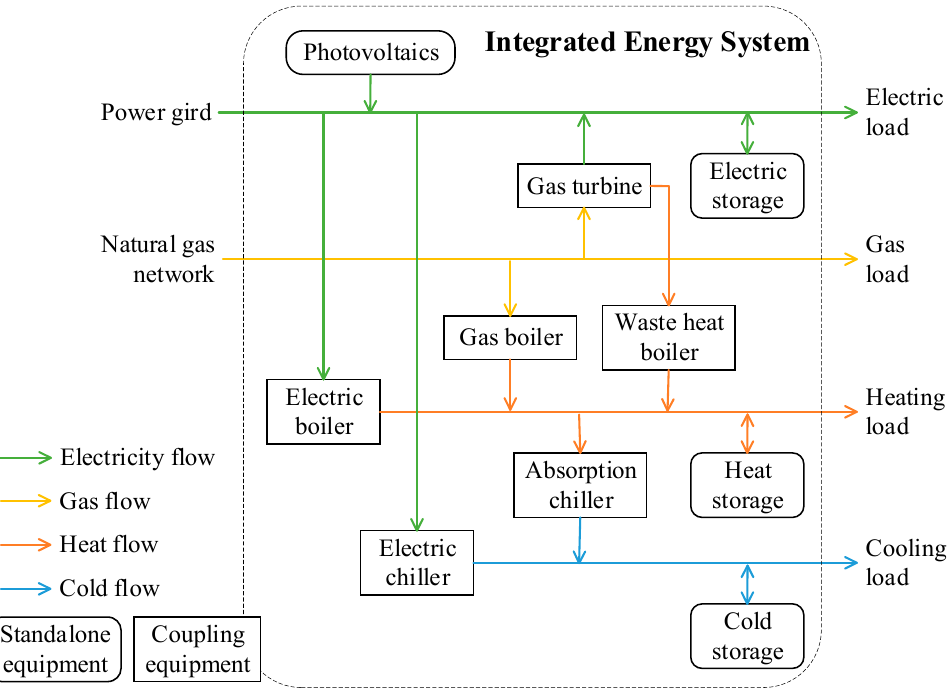
Figure 1. Structure of a sample IES.